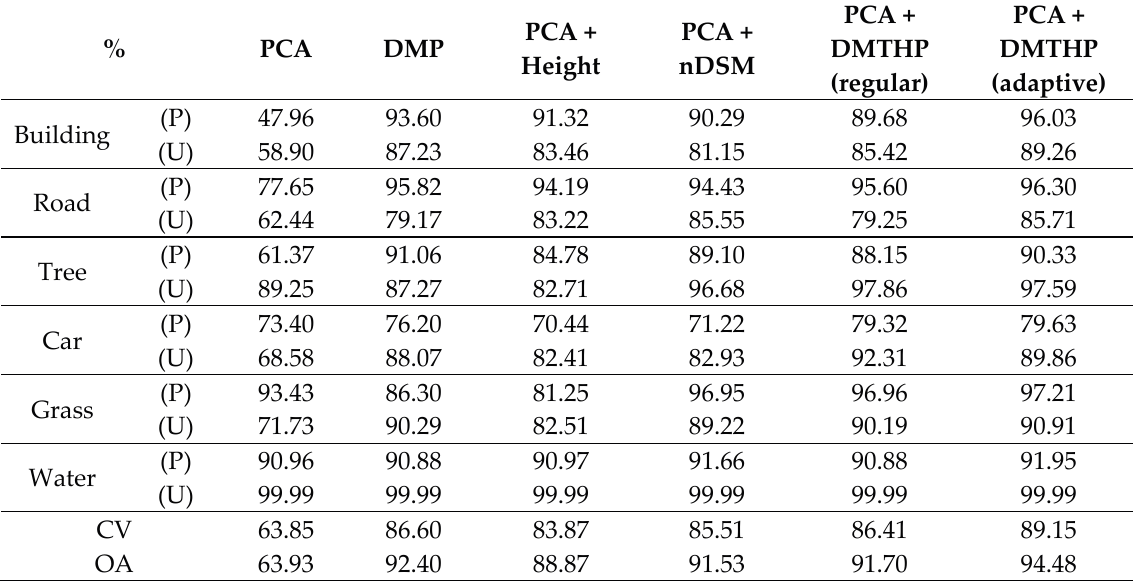
Table 5. Comparative Results of Experiment 2 (per-class producer’s (P) and user’s (U) accuracy).